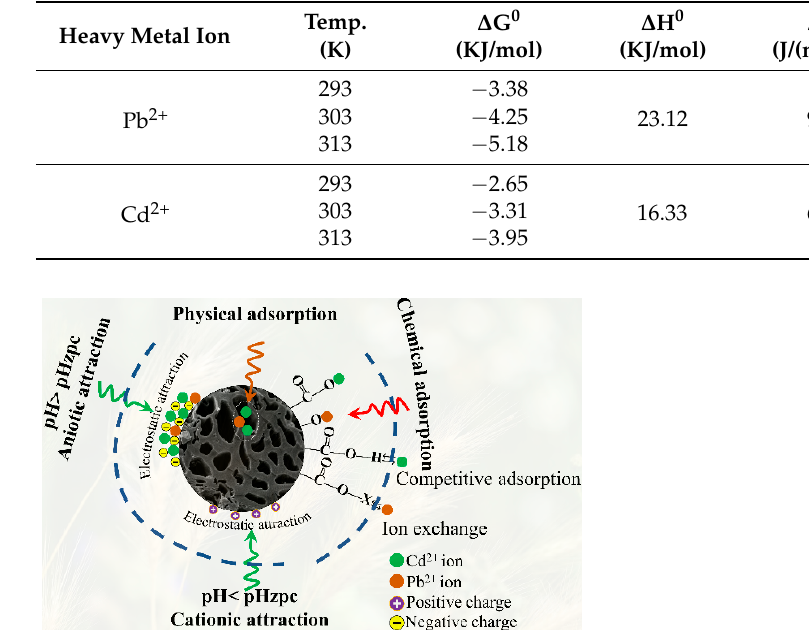
Figure 14. The adsorption mechanism of activated carbon for heavy metals.